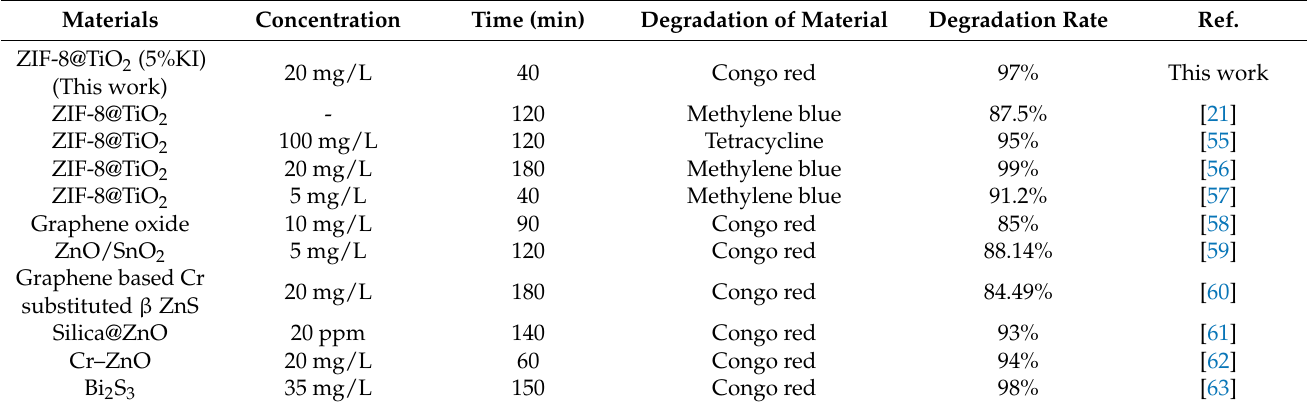
Table 4. Comparison of photocatalytic